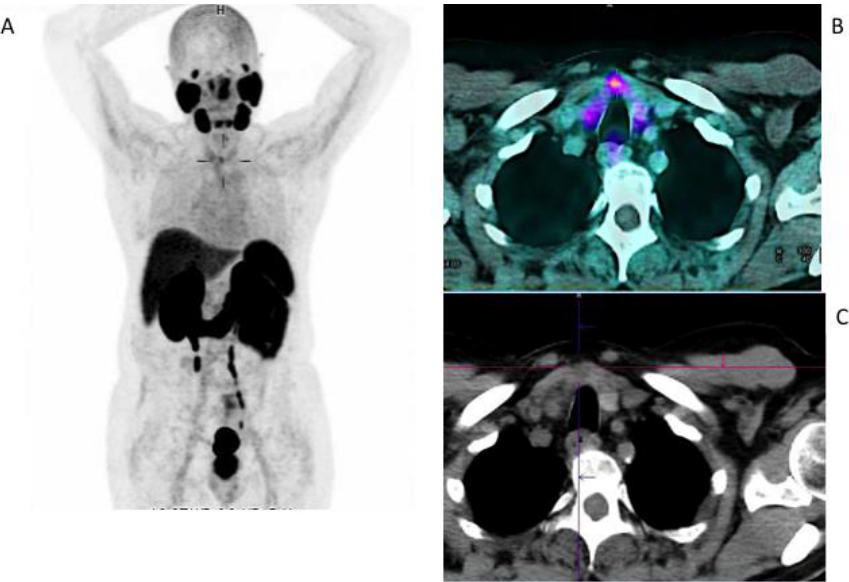
Figure 2. Incidental findings of thyroid cancer in a 63-year-old patient studied with 68 Ga-PSMA-11 for prostate cancer. MIP ( A ) and fused images ( B ) showing focal uptake (SUVmax 3.5) on the thyroid gland corresponding to a hypo-dense nodule on a co-registered low-dose CT scan ( C ). The ultrasound fine needle aspiration revealed Thy 4 (suspicious for malignancy) and the patient underwent a total thyroidectomy. The histology revealed a poorly differentiated papillary thyroid